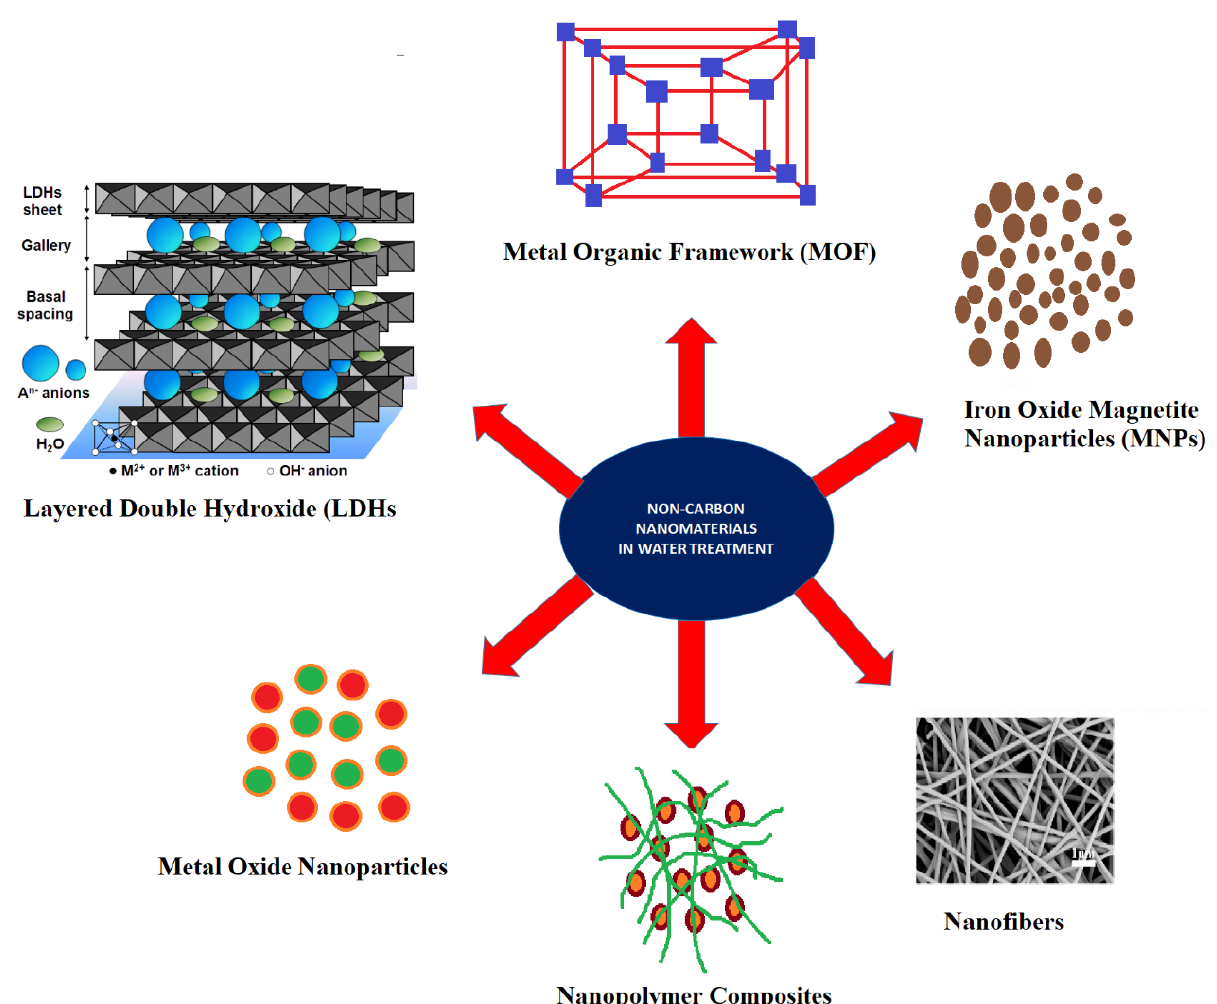
Figure 1. Different non-carbon nanomaterials, used for the treatment of heavy metal-contaminated